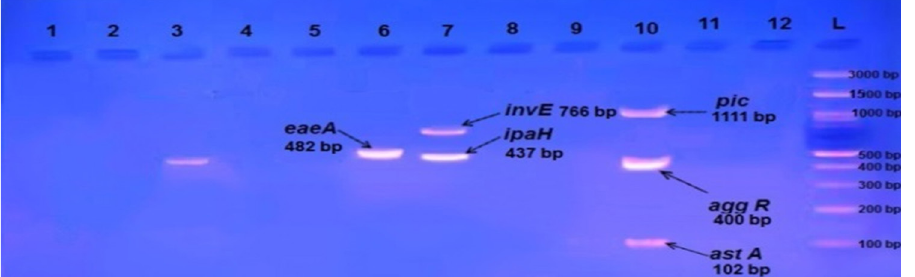
Fig. 4. Gel electrophoresis of amplified ( eaeA , bfpB, aggR, astA, pic, hly, stx1, stx2, invE, ipaH, elt ,estIa, estIb ) genes, the product size (482, 910, 400, 102, 1, 111, 688, 244, 324, 766, 437, 655, 157, 171(bp) respectively), of E .coli strains using conventional PCR. Agarose 2%, and TBE (1X) at (75 V/cm for 90 min., stained with Ethidium bromide dye and visualized on a UV transilluminator. Lane (L): DNA ladder (100-3000bp), Lanes: (1-12) stool